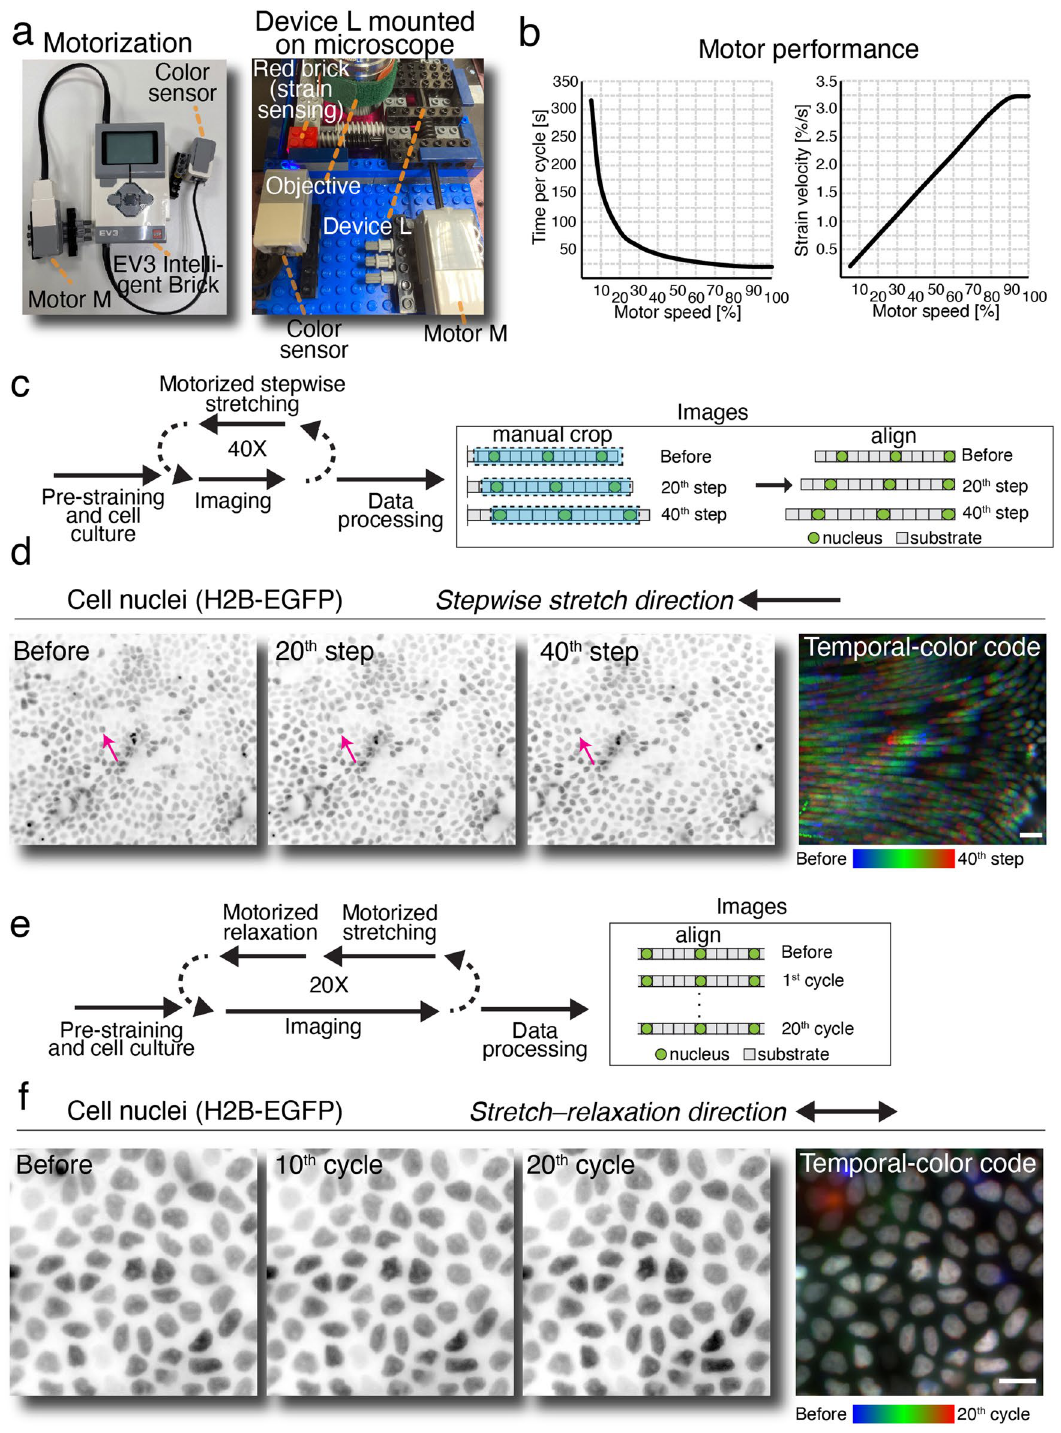
Figure 5. Automated live-cell compression studies with Brick Strex L. Motorized manipulation of MDCKII cells stably expressing histone H2B-EGFP was done by using ( a ) Brick Strex L device connected to a LEGO EV3 Intelligent Brick, motor M and color sensor (left panel; see also Supplementary Fig. 10), followed by mounting on an upright microscope stage (middle panel). ( b ) Motor performance was quantified by measuring the time for one full cycle of movement with different motor speeds. The strain velocity, measured as strain-% / s, is highly linear function of the motor speed setting. c , Scheme for the automated stepwise relaxation experiment. ( d ) Cells were grown on stretched membrane, after which the membrane was subjected to 40 relaxation steps, imaged between the steps and the data was processed by aligning the images. Arrows indicate the location of the same nucleus during stretching. Scale bar 50 µ m. ( e ) Scheme for the automated cyclic relaxation-stretching experiment. ( f ) Relaxation-stretching cycles performed for 20 times. Temporal-color code presenting the minimal nuclei movement in response to the lateral compression. Scale bar 25 µ